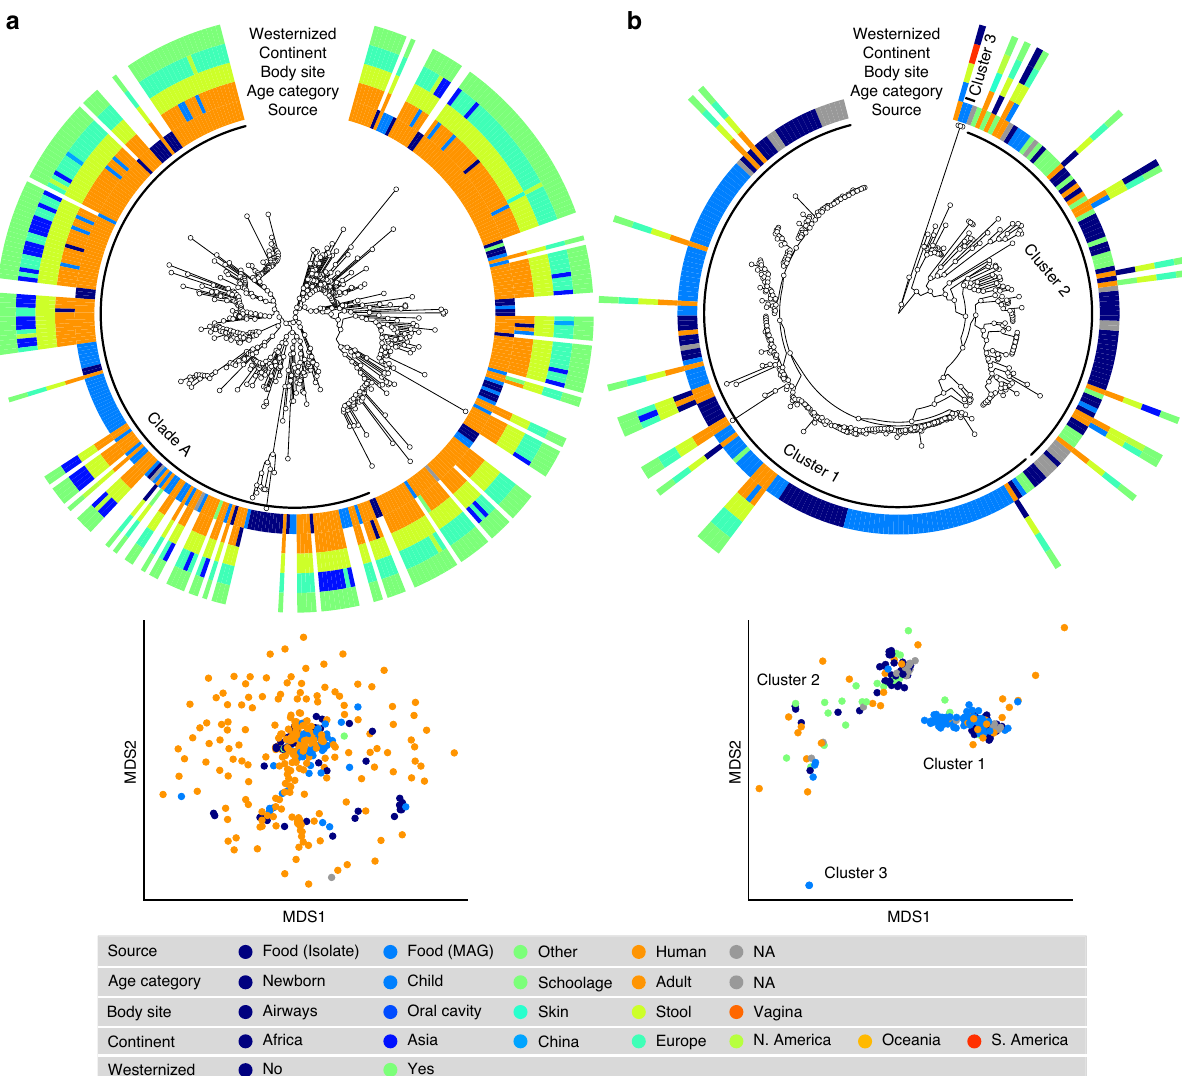
Fig. 3 Comparative genomic analysis of the two most prevalent LAB identi fi ed in the human gut microbiome. a S. thermophilus is a genetically diverse species both in food and human sources with MAGs reconstructed from Asian gut metagenomes enriched in Clade A ( p < 1e − 10). b Lc. lactis subsp. lactis is formed by three main clusters: Cluster 1 exhibits an overall low diversity and includes mostly food genomes related to cheese and dairy fermentation; Cluster 2 is dominated by environmental and raw vegetable products and more diverse human MAGs; Cluster 3 includes only two MAGs from nunu. Phylogenetic trees were built on species-speci fi c marker genes and report fi ve different metadata. Multidimensional scaling (MDS) on average nucleotide identity (ANI) distance is coloured with source